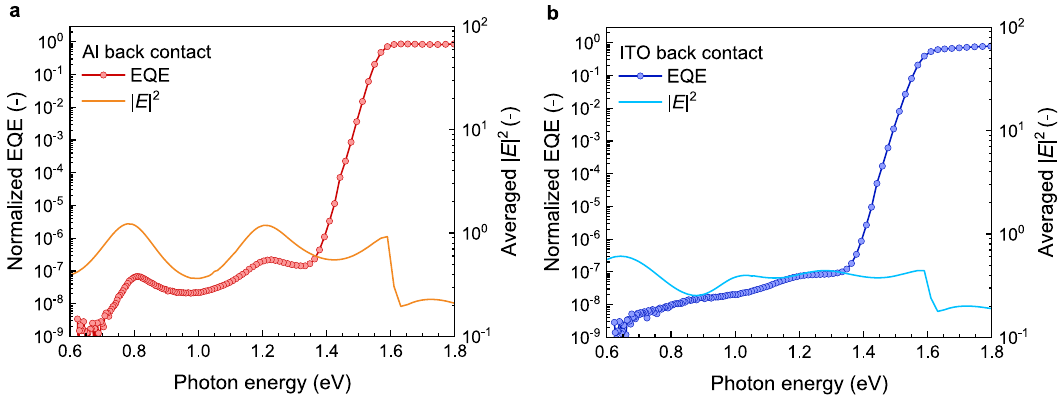
Fig. 1 Experimental EQE and averaged simulated | E | 2 of a p – i – n perovskite solar cell with a glass/ITO/PTAA/FA 0.67 MA 0.33 PbI 2.85 Br 0.15 /PCBM/AZO/ back electrode con fi guration. a For an Al back electrode. b For an ITO back electrode. The variation in | E | 2 is much larger when using Al as the back electrode than for ITO due to the higher re fl ectivity of Al. The modeled interference peaks line up well with peaks in the measured EQE. | E | 2 has been averaged over the full thickness of the